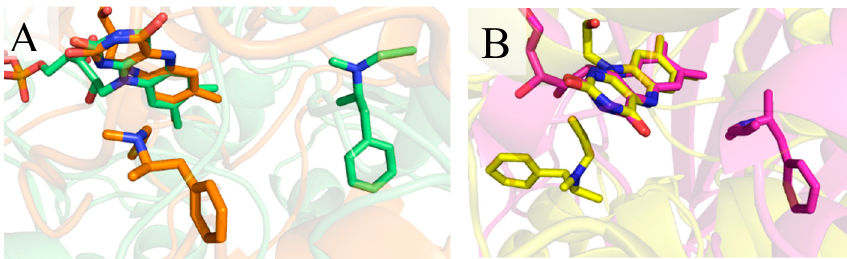
Figure 14. Overlay of selegiline in MAO-A and MAO-B. ( A ) Selegiline locations in the active sites of oxidized MAO, with MAO-A as green sticks and MAO-B as orange sticks. ( B ) Allenyl-selegiline locations in reduced MAO, with MAO-A as magenta sticks and MAO-B as yellow sticks.